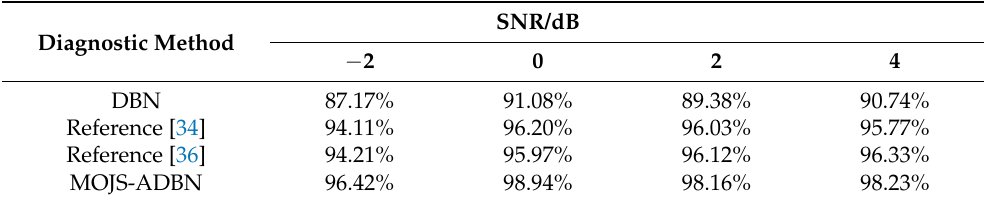
Table 4. Diagnosis accuracy rates of different methods under different